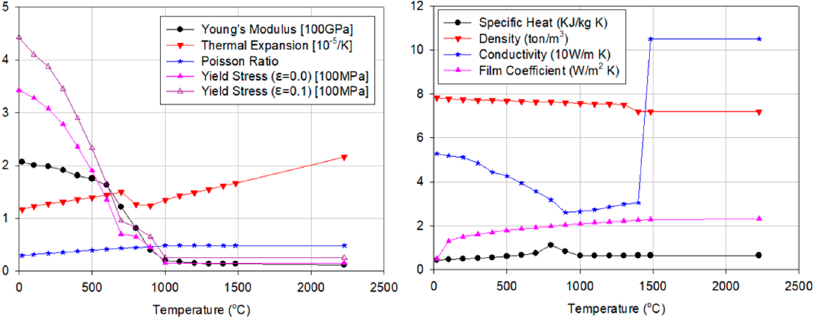
Figure 10. Temperature-dependent material properties.